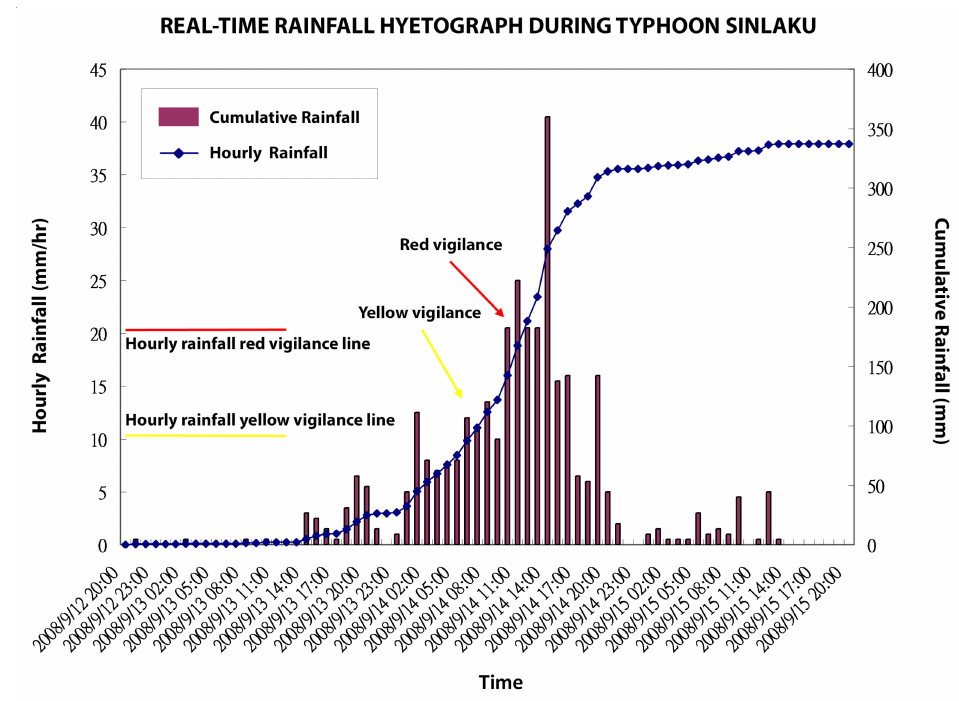
Figure 12. Real-time rainfall hyetograph during Typhoon